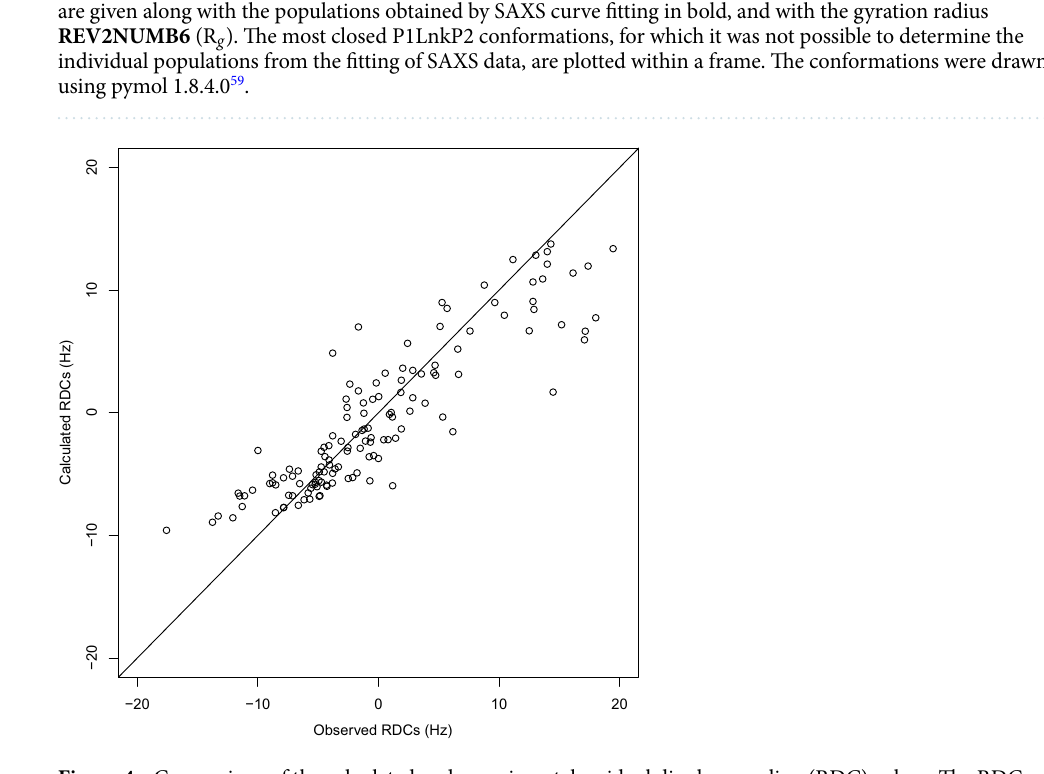
profiles. RMS, R and Q factors have been calculated for each MSTL spin label and each closed conformation (Table S3). For most spin labels and protein conformations, reasonable R correlations were obtained. The RDC values have been recalculated on the conformations 12, 13, 24, 140, 176 using the software PALES and averaged according to populations displayed in Fig. 3. The comparison of calculated and observed RDC values (Fig. 4) reveals a reasonable agreement between the two sets of values, with a RMS of 4.1 Hz, a R factor of 0.8 and a Q factor of 0.5. The analysis of the agreement with RDCs for individual conformations (Table S4) reveals R correlation factors larger than 0.9 for all closed conformations and conformation 140 and larger than 0.8 for conformation 176.